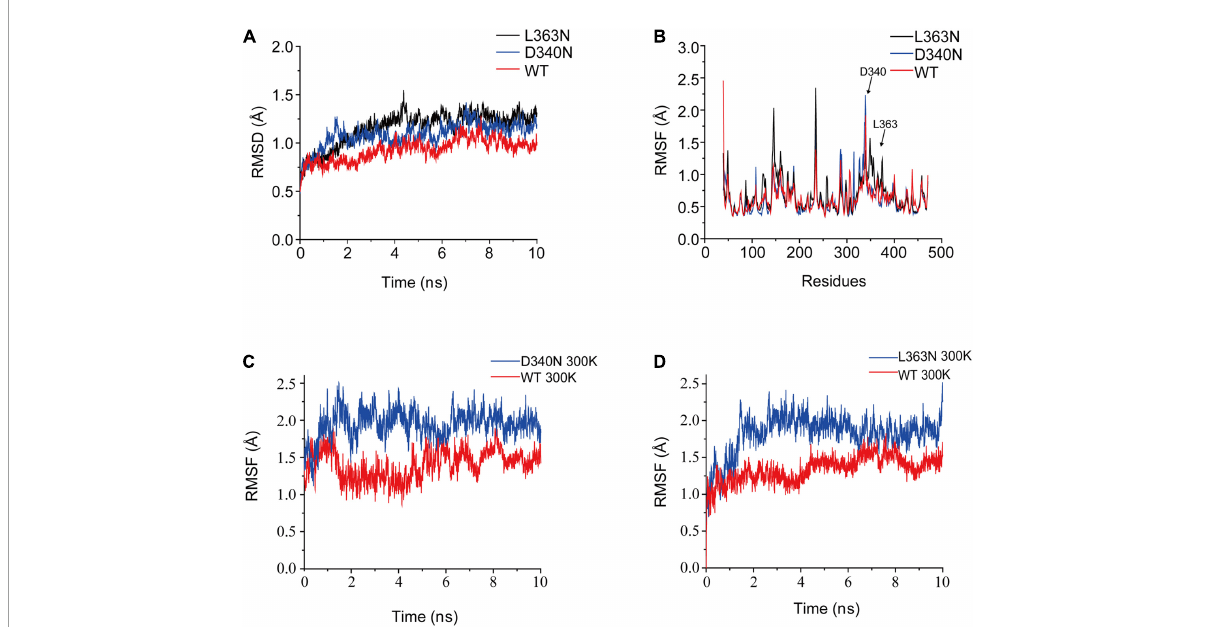
FIGURE5 The RMSD and RMSF values for L -amino acid deaminase ( L -AAD) and its mutants. The RMSD (A) and RMSF (B) values for the whole protein L -AAD and its mutants. (C) The RMSD of loop D340 for the wild-type L -AAD and D340N. (D) The RMSD of loop L363 for the wild-type L -AAD and L363N.